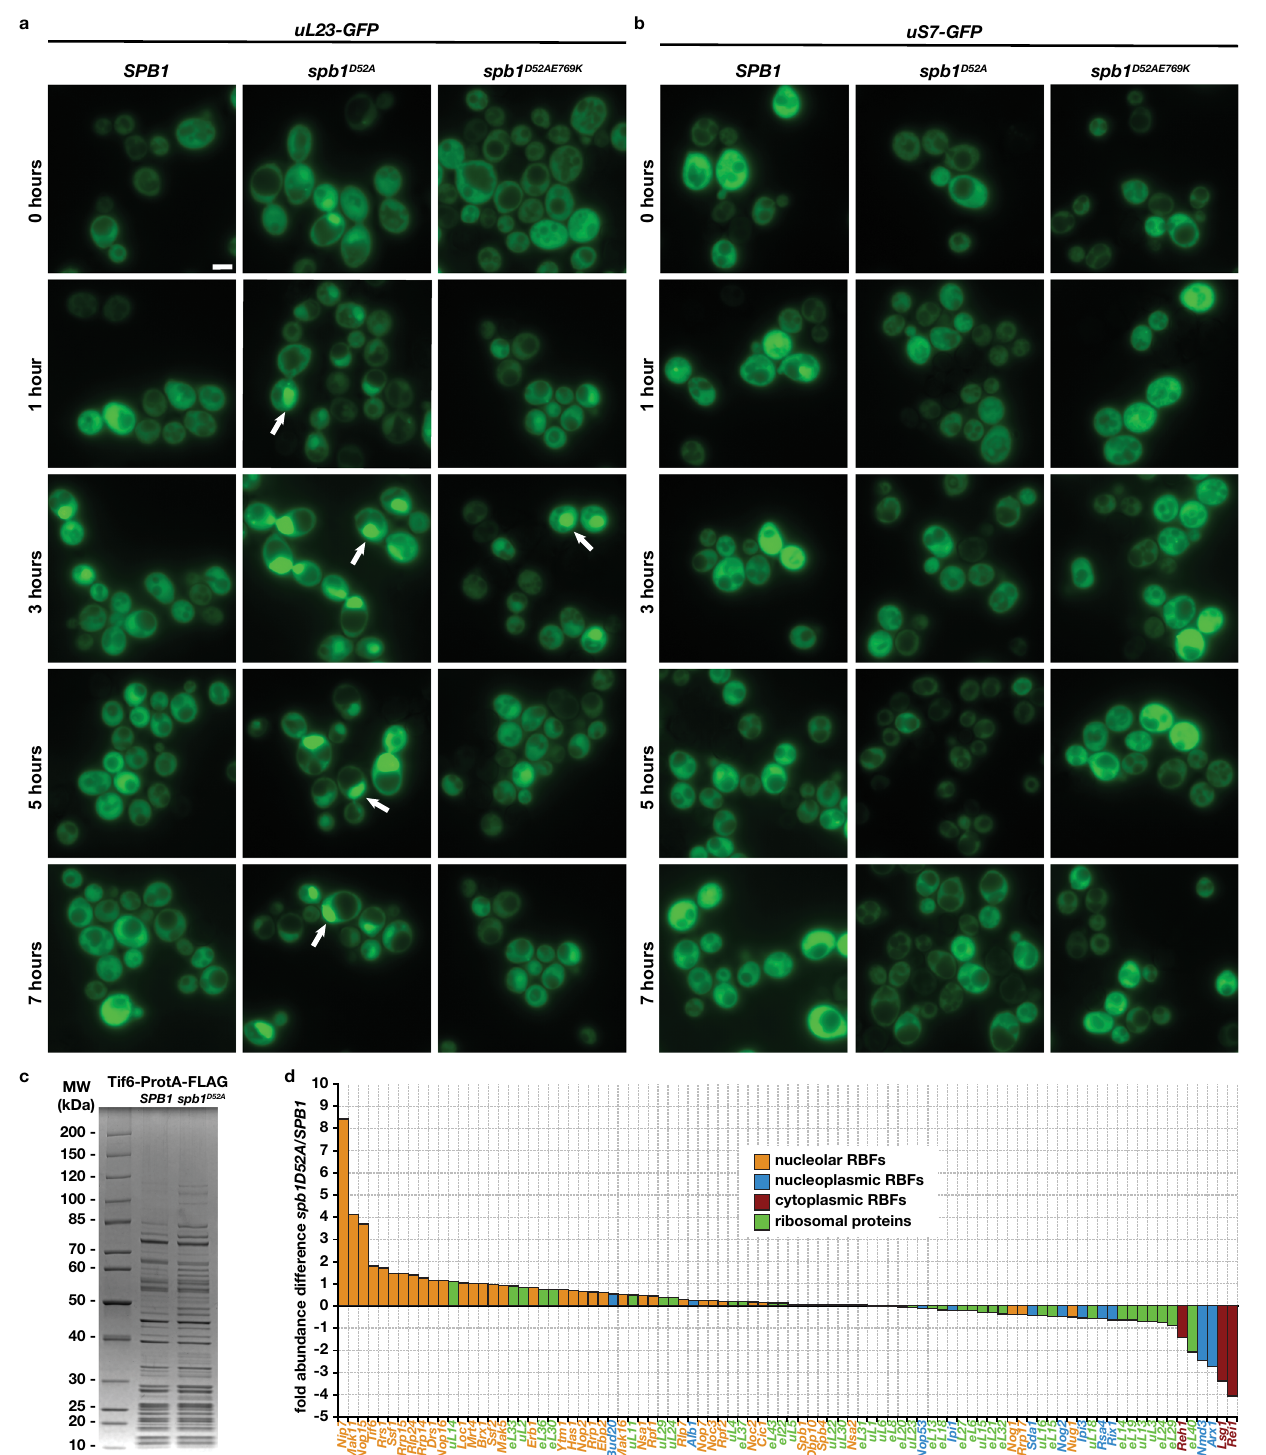
Fig. 5 | Nuclear accumulation of pre-60S intermediates. Time course of the invivodistributionofGFP-taggedlarge( a )andsmall( b )ribosomalproteinsin SPB1 , spb1 D52A , and spb1 D52A/E769K cells after dilution of a saturated culture into fresh media (at t=0hours). White arrows indicate representative cells with nuclear accumula- tion of GFP signal. Images are pseudo-colored and scale bars represent 5 µ m. c Coomassie-stained SDS-PAGE gel of tandem-puri fi ed Tif6-containing pre-60S intermediates from SPB1 and spb1 D52A cells. Identical samples were analyzed by